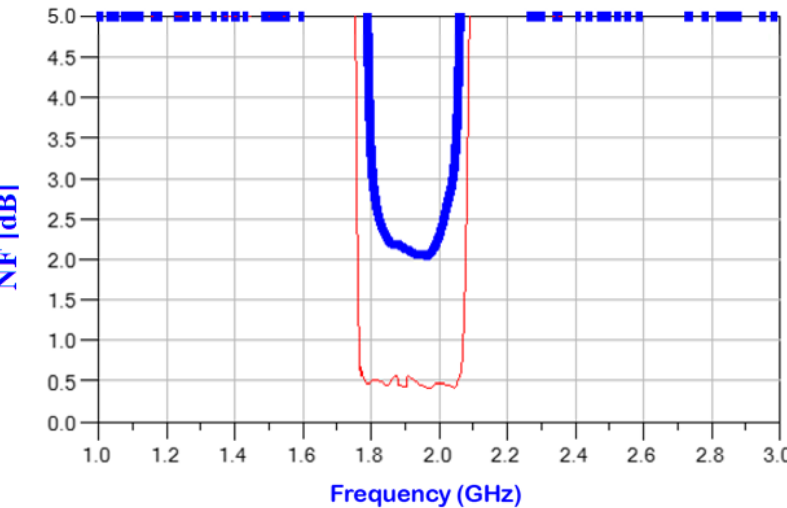
Figure 7. Comparison of noise figures of a superconductor-based (thin red) and a copper-based (thick blue) RF head.